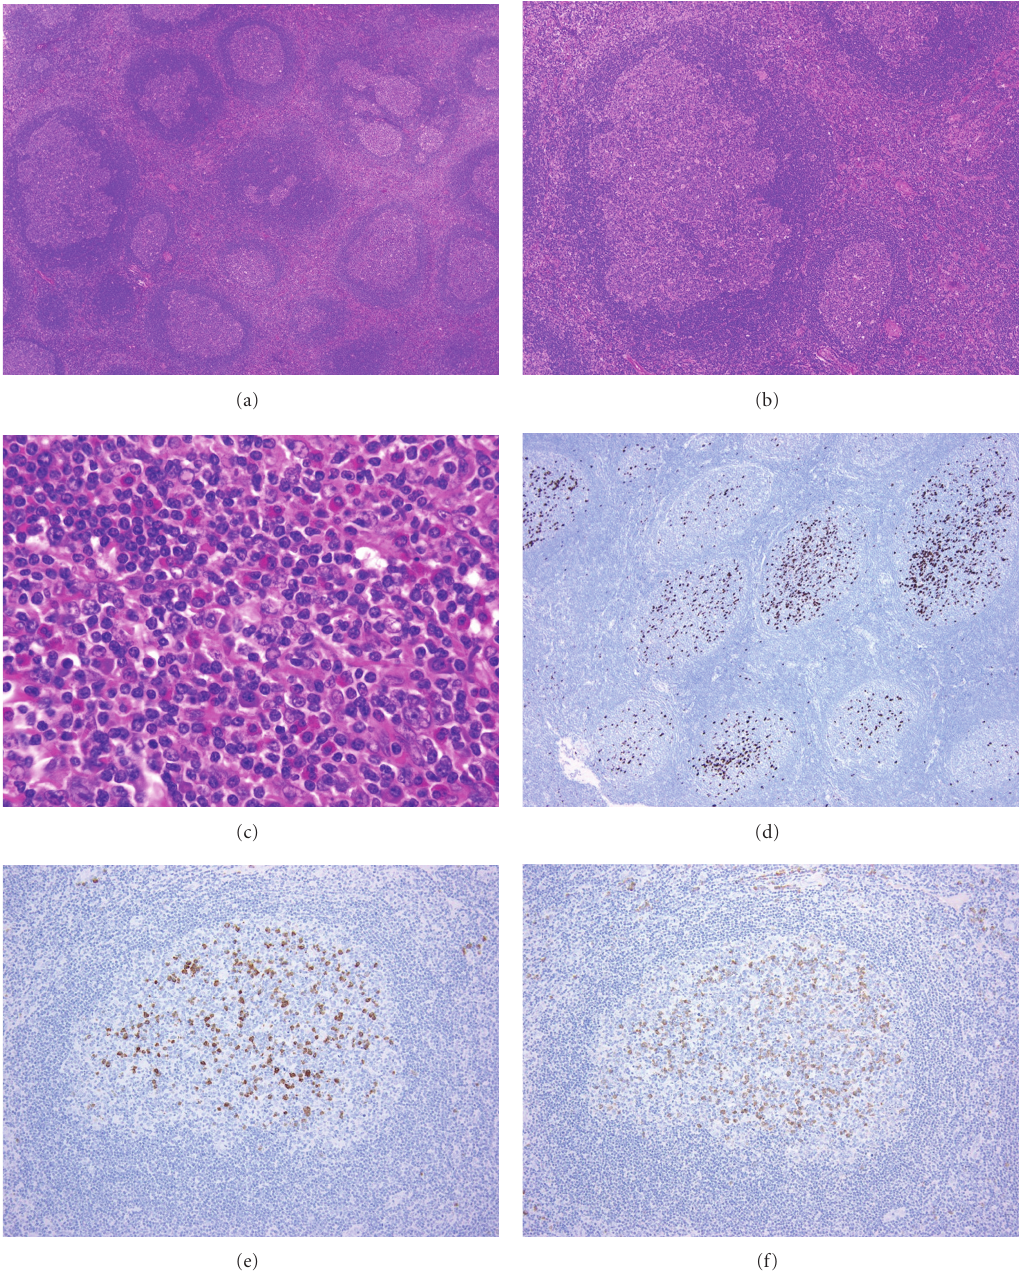
Figure 4: IgG4-related lymphadenopathy (type IV). (a) The lymph node shows marked follicular hyperplasia with PTGC. (b) The PTGCs appear as round to oval structures 2-3 times the diameter of the other reactive follicles. (c) Numerous eosinophils infiltrate the interfollicular zone. (d) The majority of IgG4 + plasma cells reside in the germinal centers, with a small number present in the interfollicular zone. (e), (f): The IgG4 + /IgG + plasma cell ratio is > 40% (e: IgG4-immunostain, f: